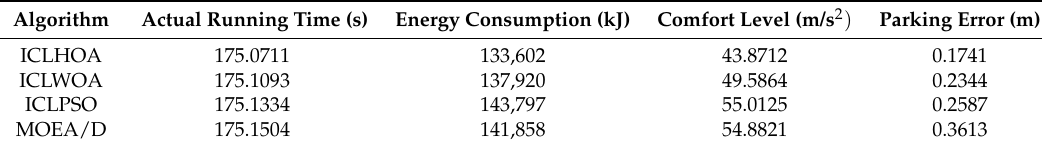
Table 9. The tracking MPC results of the velocity ideal trajectory profile obtained by partial algorithms under RCL-HILS (peak time period).